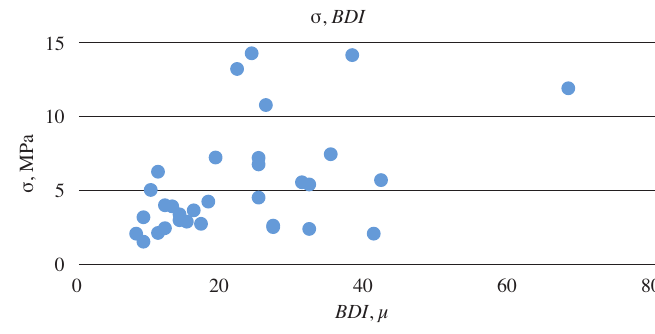
Figure 1. Relationship between BDI and compressive strength of